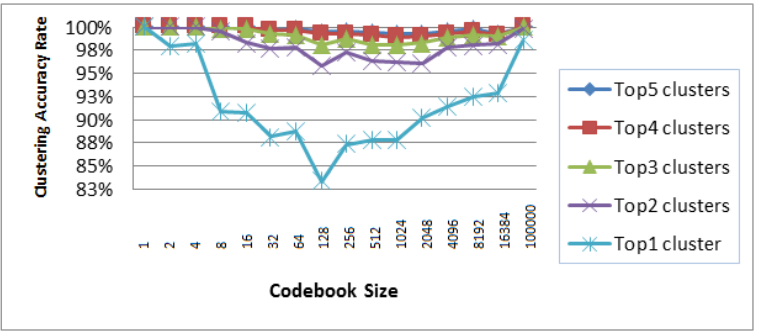
Figure 4. Clustering accuracy rate of Simplified Arabic font vs. codebook size number using DCT+ DCT_4B feature for different top